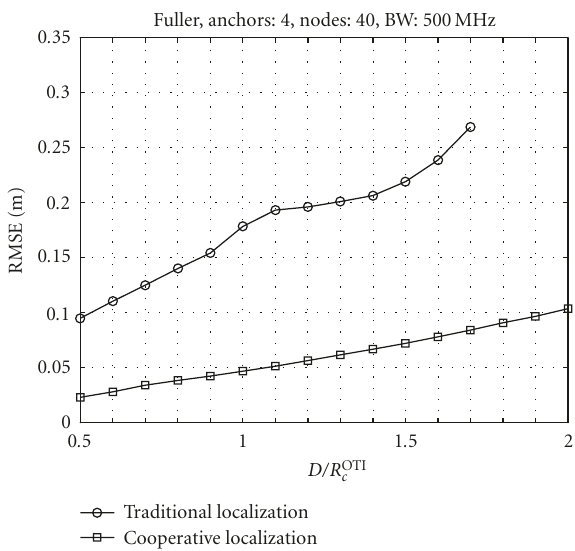
Figure 4: Traditional triangulation versus cooperative localization